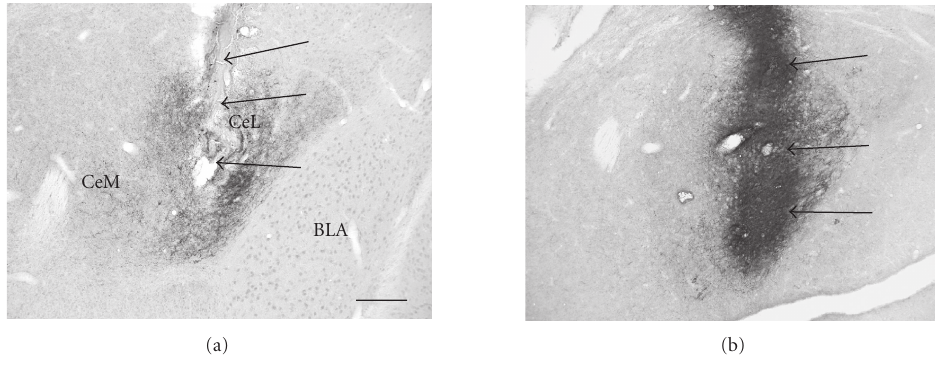
Figure 1: Histological verification of an injection site produced by microinjected synthetic PACAP. (a) Section from control brain, injected with aCSF vehicle. (b) Injected synthetic PACAP (50 pmol) immunoreactivity in the CeA. BLA = basolateral nucleus of the amygdala, CeM = central nucleus of the amygdala medial part, CeL = central nucleus of the amygdala, lateral part. Note the presence of high density of endogenous PACAP fibers in both (a) and (b). Arrows indicate the location of cannula track. In (b), synthetic PACAP injection is visible as an intense dark reaction product. Scale bar = 200 µ